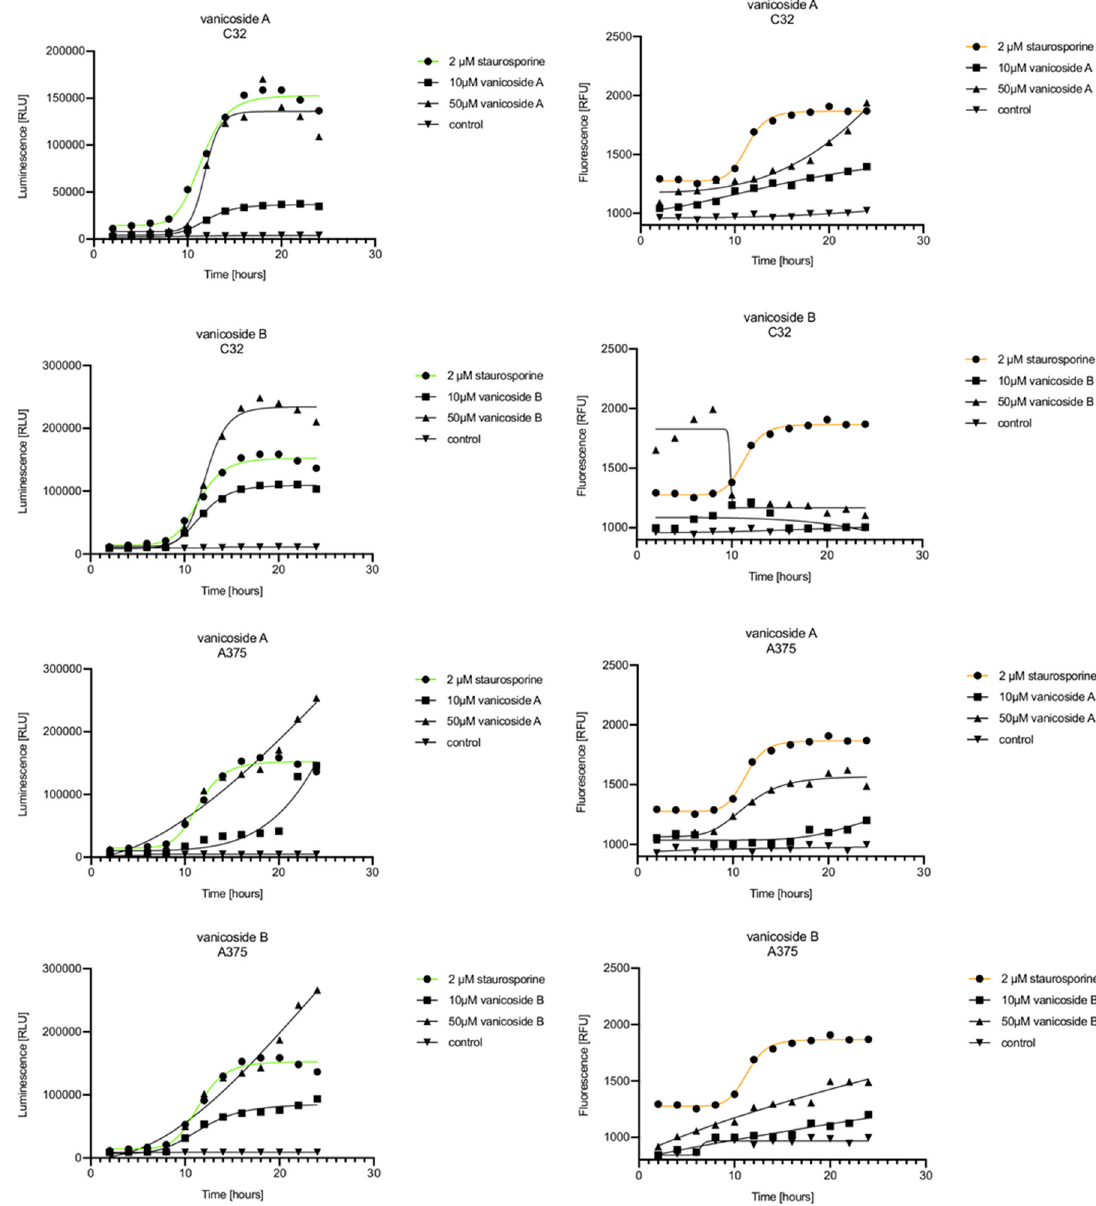
Figure 5. Real-time monitoring of luminescence (A) and fluorescence (B) signals measured for the C32 and A375 cell lines treated with 10 and 50 µ M of vanicoside A and vanicoside B over 24 h, reported in relative luminescence units (RLU) and relative fluorescence units (RFU), respectively. Staurosporine (2 µ M) was used as the positive control–an apoptosis-inducer. The term “control” means cell lines without treatment of vanicosides. Negative control for staurosporine was not presented.